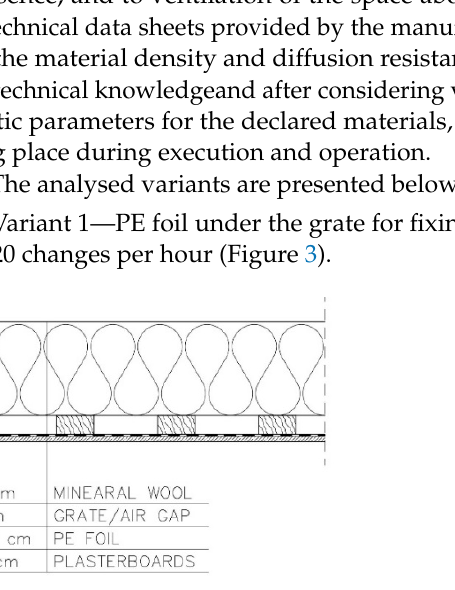
Figure 4. Variant 2: PE foil above the grate for fixing plasterboards. Roof ventilation equal to 20 changes per hour. Figure 5. Variant 3: PE foil under the grate for fixing plasterboards. Mineral wool fills the air gap formed by the grate. Roof ventilation equal to 20 changes per hour.